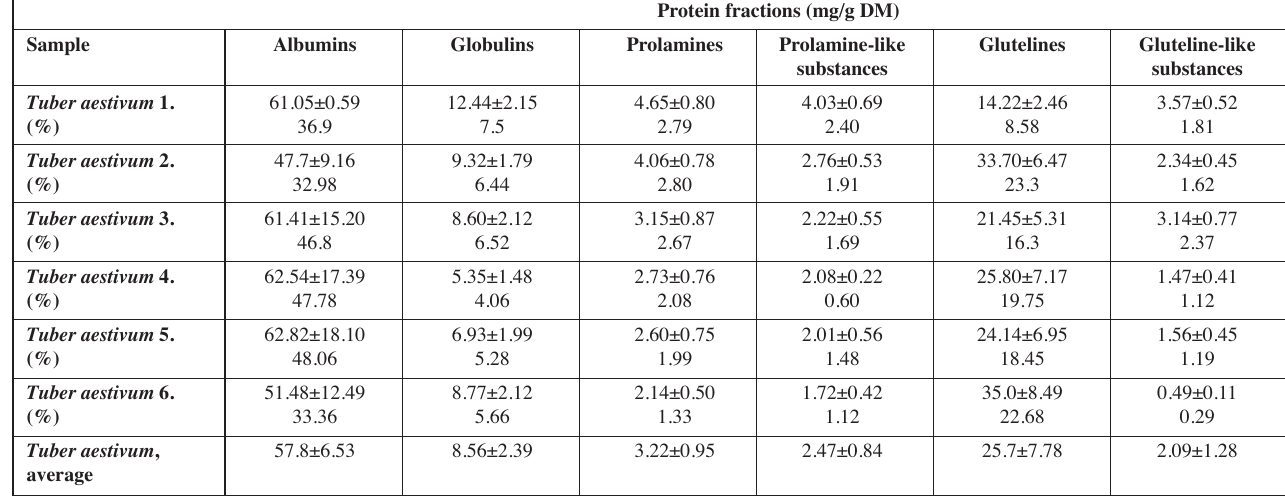
Tab. 2: Different protein fractions of Tuber aestivum (mg/g DM) (mean ±SD and in percent of crude protein content (%))